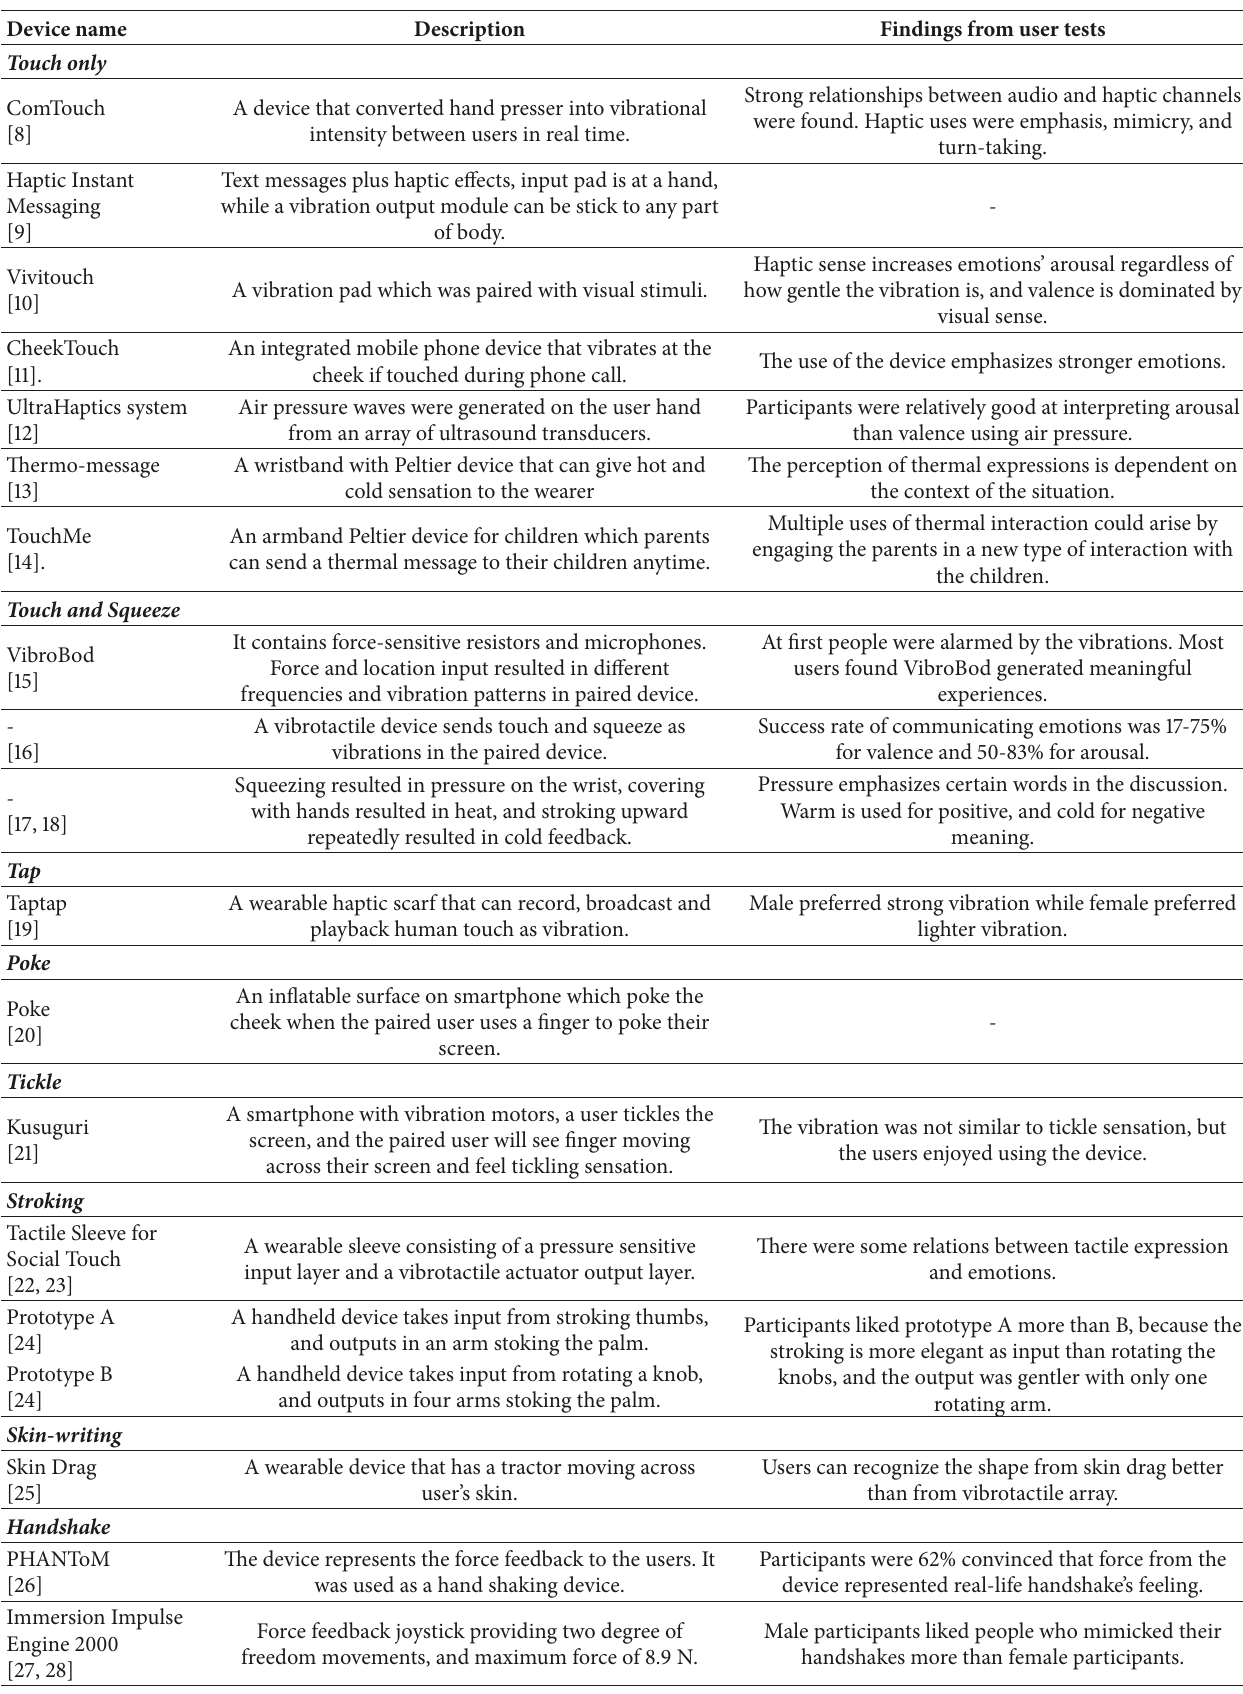
Table 1: Existing haptic communication devices categorized by interactions